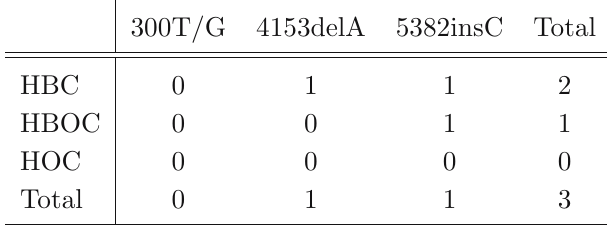
Table 3 Detailed distribution of BRCA1 mutations in patients with suspected